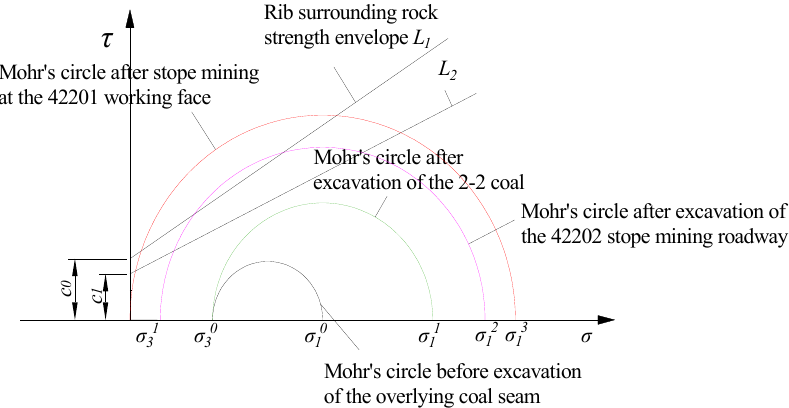
Figure 7. Changes in the stress state and strength of roadway surrounding rock under multiple